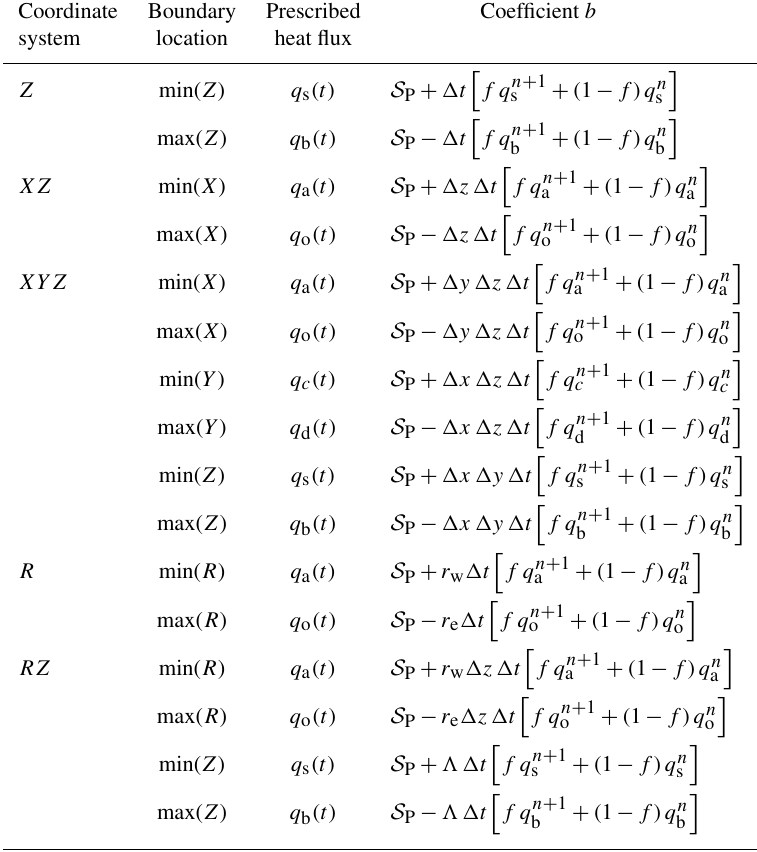
Table 4. Discretization coefficient b for a control volume adjacent to a prescribed heat-flux (Neumann) boundary